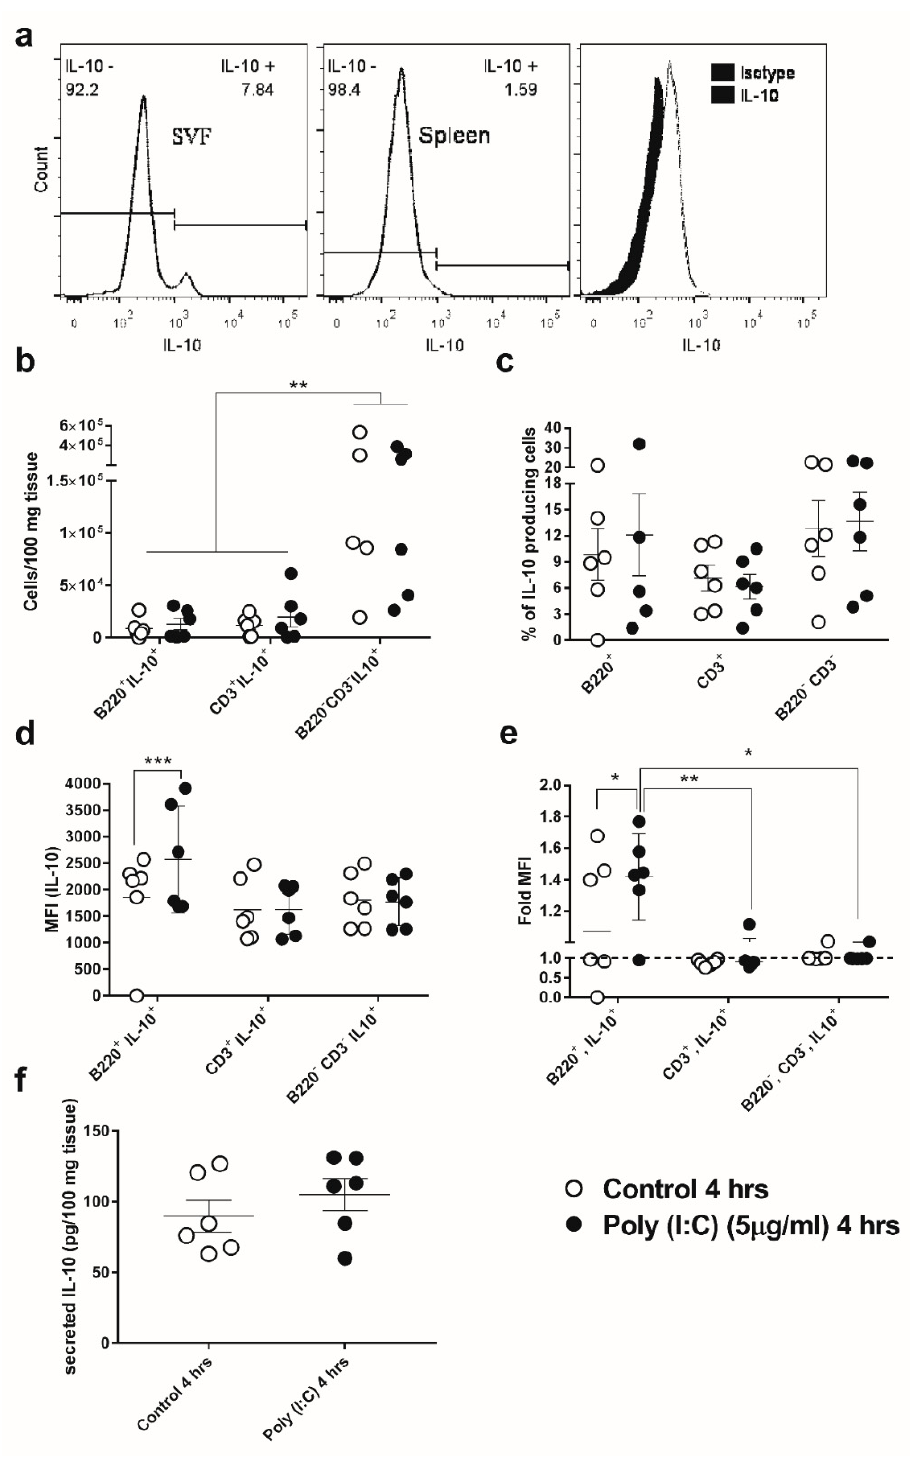
Figure 3. IL-10 expression in murine viable immune cells from the stromal vascular fraction (SVF) of GWAT explants after ex vivo exposure to 5 µg/mL of poly(I:C) for 4 h. ( a ) Murine B-cells (B220 + ) that express IL-10 are relatively more abundant in the GWAT SVF than in the splenocytes of the same mice. In these assays, samples were control-stained with isotype antibodies not specific to IL-10. Histograms are representative of the results obtained in all assays. ( b ) Total number of IL-10-expressing B-cells (B220 + IL-10 + ), T-cells (CD3 + IL-10 + ), and other cells in GWAT SVF (B220 − CD3 − IL-10 + ). ( c ) Percentage of total IL-10 expressing cells within each phenotype tested. ( d ) Level of IL-10 intracellular expression measured as the median fluorescence intensity (MFI) for B-cells, T-cells, and other cells. ( e ) MFI values in each group of cells was normalized against the average MFI for all cells